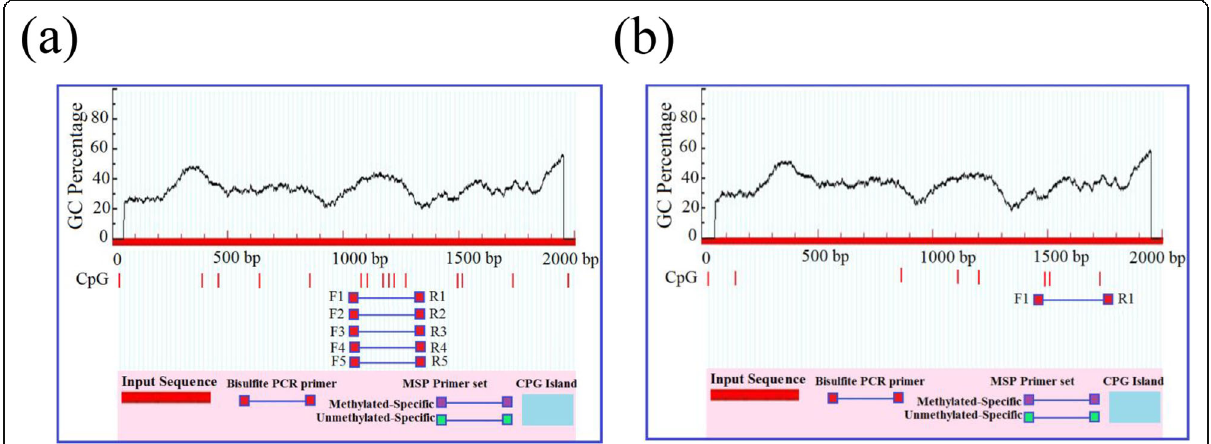
Fig. 2 a Cow sequence length 3.0 kb, CpG island prediction result, no CpG island were found, criteria used: island size > 100, GC percent greater